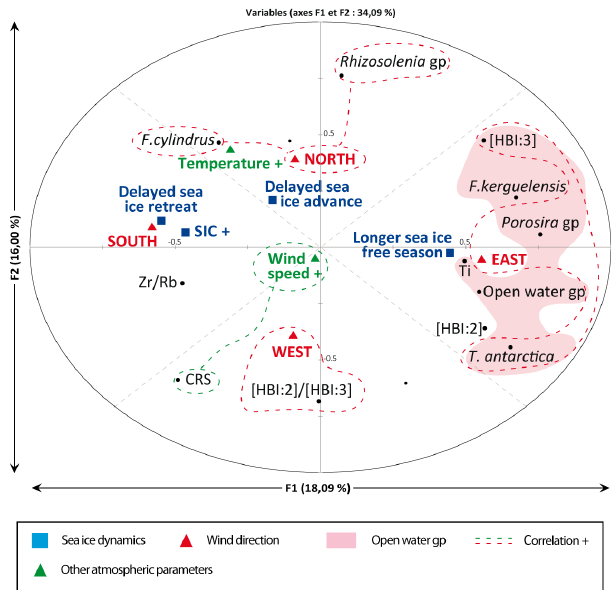
Figure 4. PCA applied to standardized sedimentary data from the DTCI2010 core and meteorological parameters. The yearly stan- dardized sedimentary data represent the ice-free season of the re- lated year. Weather forecast/satellite data were averaged between November and March. F1 axis represents the sea ice conditions linked to the predominant easterly and southerly winds. F2 axis rep- resents the secondary wind directions in the study area, northerly and westerly